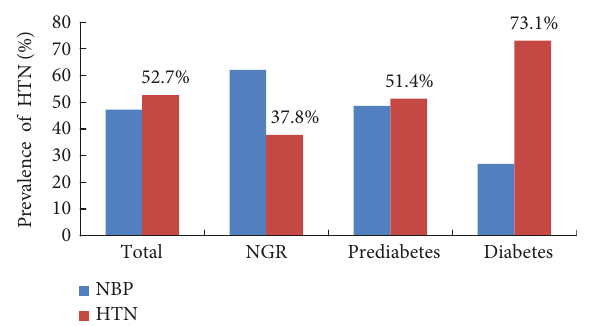
Figure 1: Prevalence of HTN in NGR, prediabetes, and type 2